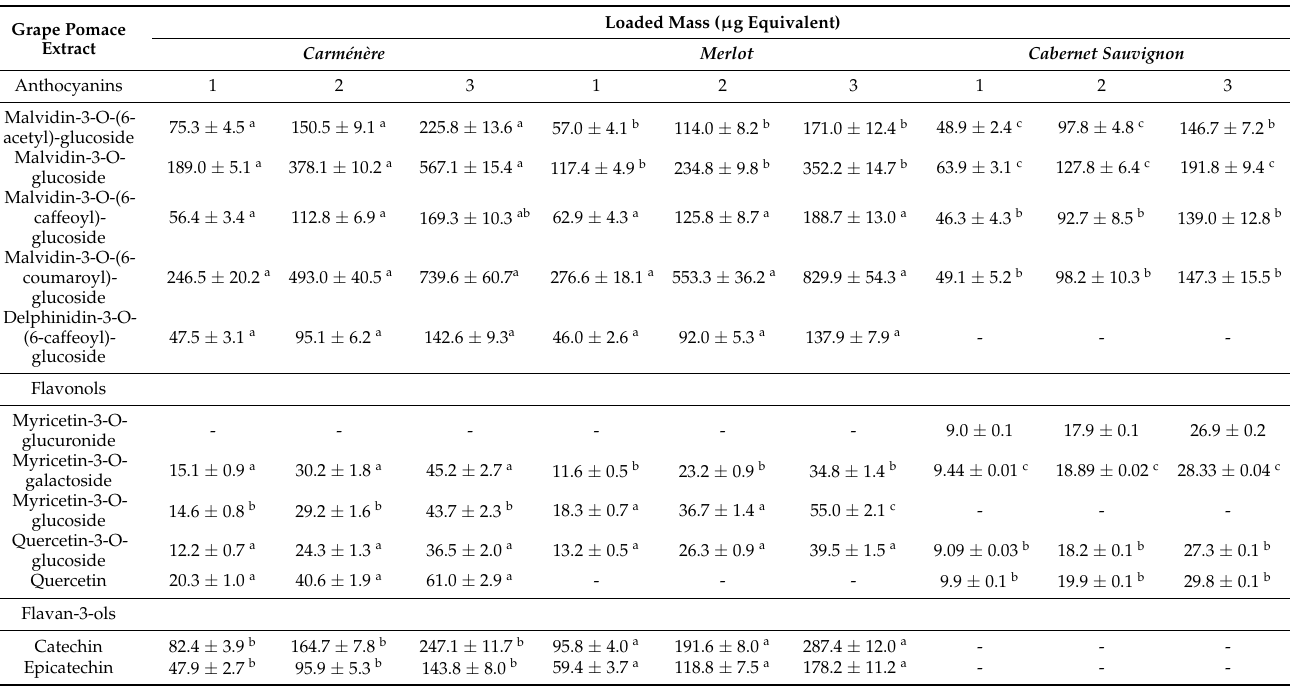
Table 3. PC content from the extract loaded in the PVPP. Quantification by